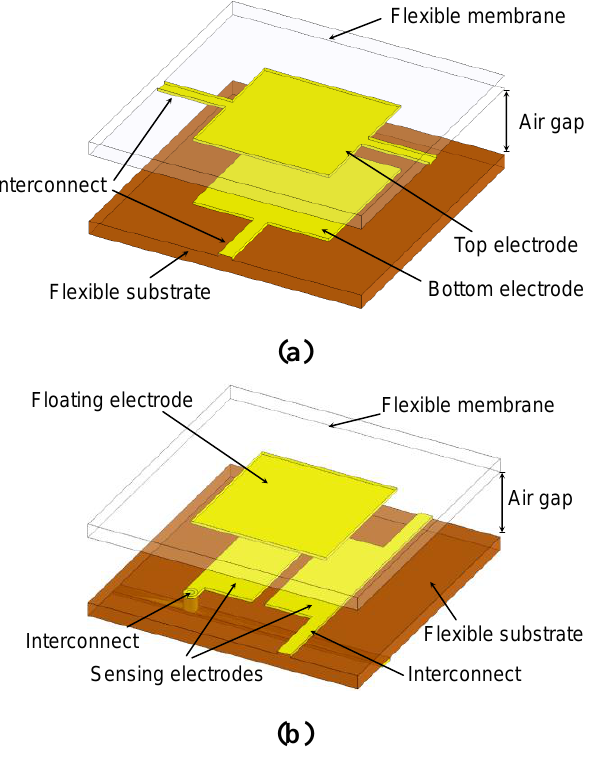
Figure 2. (a) The schematic of a typical parallel-plate capacitive mechanism (PCM). (b) The schematic of the proposed pseudo-parallel-plate capacitive mechanism